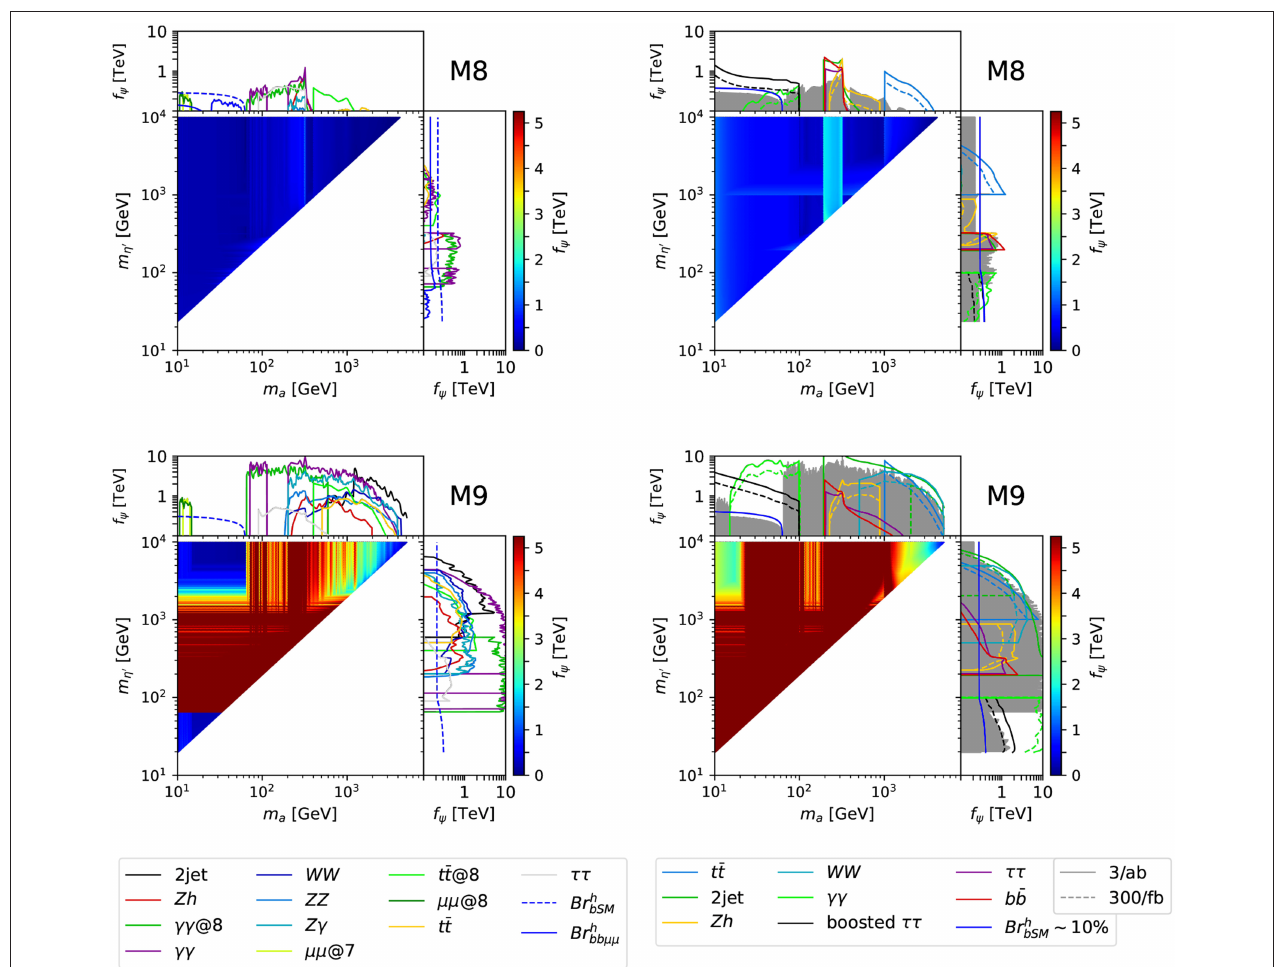
FIGURE 3 | Heat-plots showing the lower bounds on the Higgs decay constant f ψ in the mass plane of the two pseudo-scalars. The white triangle is not accessible by the masses in each model. The side-bands show the limits from each individual final state. On the left column, we show the current Run-I and Run-II bounds; on the right column, we show the projections at the High-Luminosity LHC run (the solid gray band summarizes the current bounds for comparison). More details in the text. Here we show model M8 (top row) and model M9 (bottom